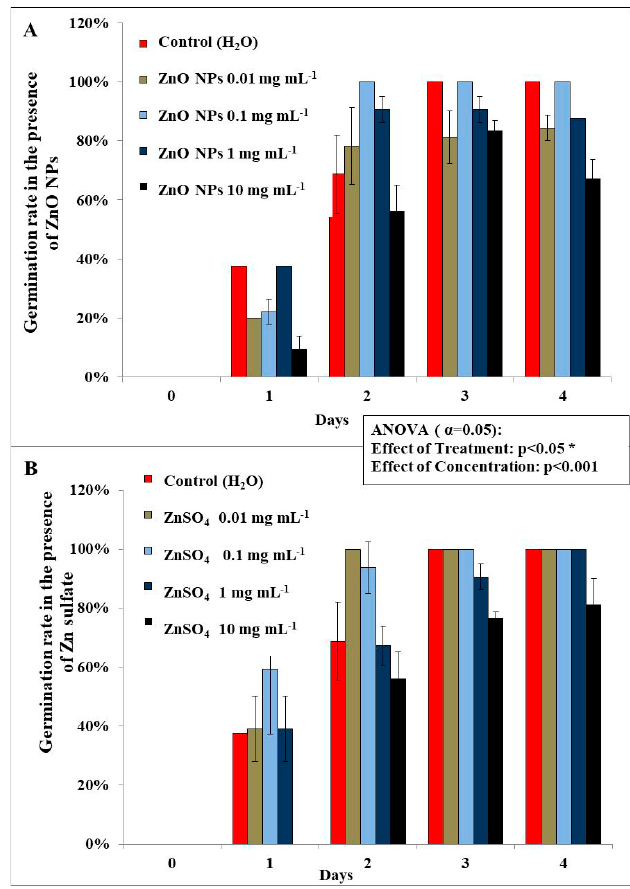
Fig. 1: Germination rate of Lathyrus sativa L. seeds during time (days) in the presence of distilled water (Control) or different concentrations of ZnO NPs and ZnSO 4 ; 0.01 mg ml -1 , 0.1 mg ml -1 , 1 mg ml -1 and 10 mg ml -1 . Values are means (±SD) which are average of two inde- pendant germinations. Differences between treatments and within concentrations estimated according to Duncan test (α=0.05) were non significant ( P <0.05).